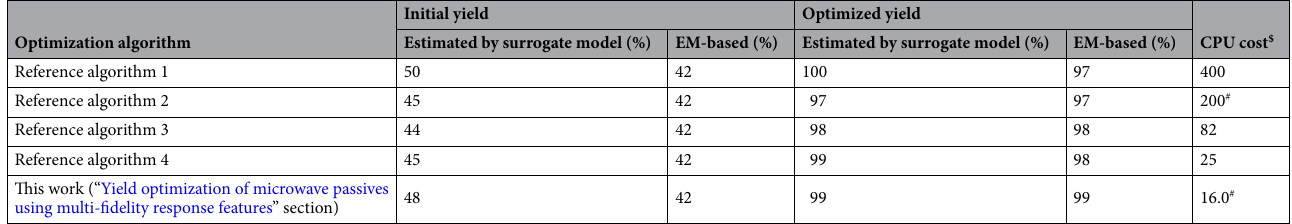
Table 4. Design centering results for Circuit I (Fig. 5a). $ Optimization cost in number of EM simulations of the considered circuit. # Equivalent number of high-fidelity EM simulations (actual number of analyzes was 6 high-fidelity and 28